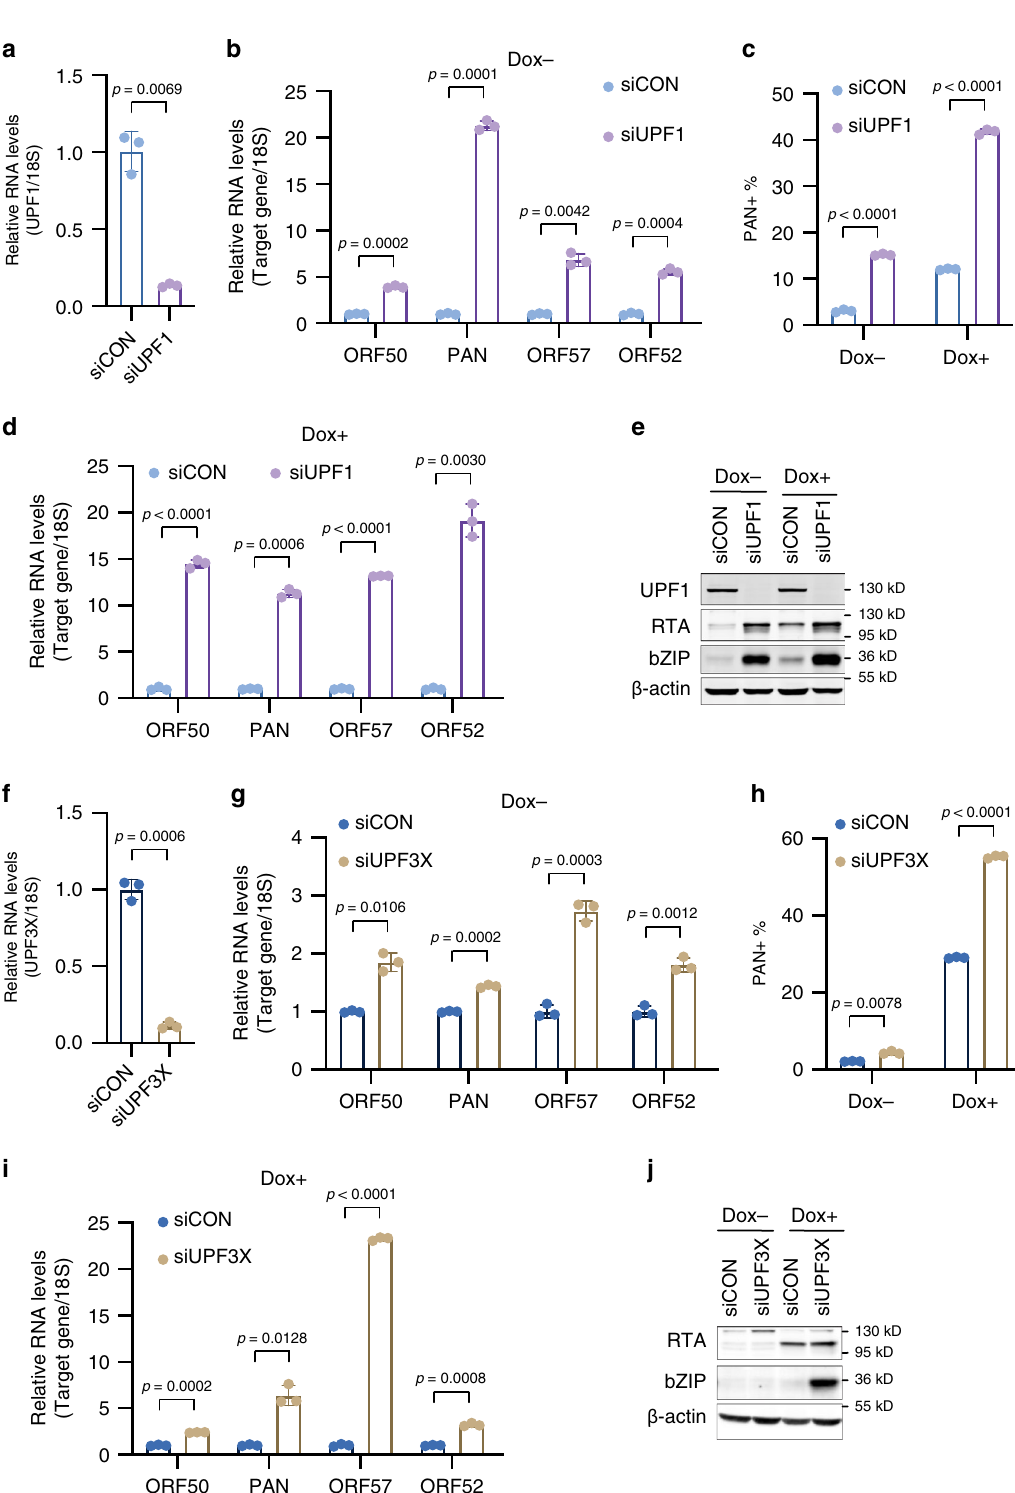
cells at 24 and 48 h post-induction, respectively, and viral gene expression was quanti fi ed by RT-qPCR and western blot analyses (Fig. 3d, e). UPF1 depletion resulted in a signi fi cant increase in lytic RNA expression compared to siCON-treated cells, and an increase in the protein levels of RTA and bZIP were con fi rmed by western blot analyses. In addition, by RNA FISH-FLOW we observed a ~4-fold increase in PAN RNA expressing lytic cells 24 h post-induction (Fig.